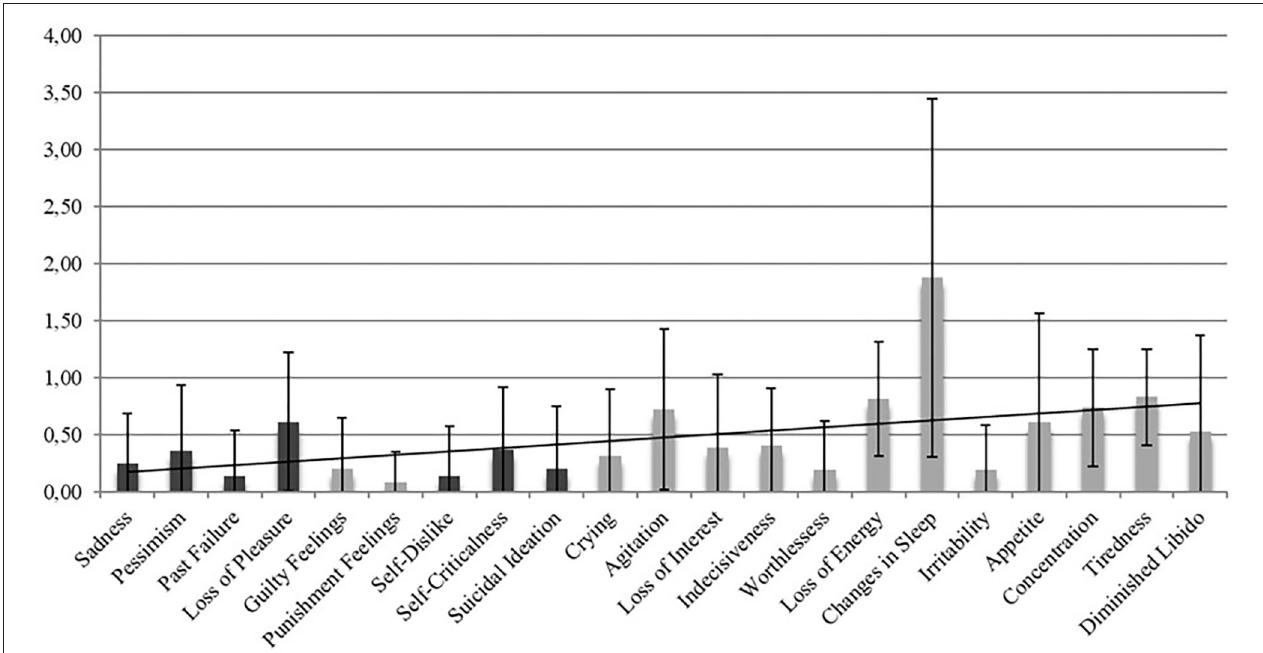
FIGURE 2 | Mean item score values for all items of the BDI-II. The x-axis represents the 21 items of the BDI-II and the 7 BDI-FS items Sadness, Pessimism, Past Failure, Loss of Pleasure, Self-Dislike, Self-Criticalness, and Suicidal Ideation (dark columns) . The y-axis depicts the mean scores (and standard deviation) on the individual items with scores ranging from 0 to 3. The items in the second half of the questionnaire address somatic symptoms and mostly received higher scores in our sample than the non-somatic items of the first